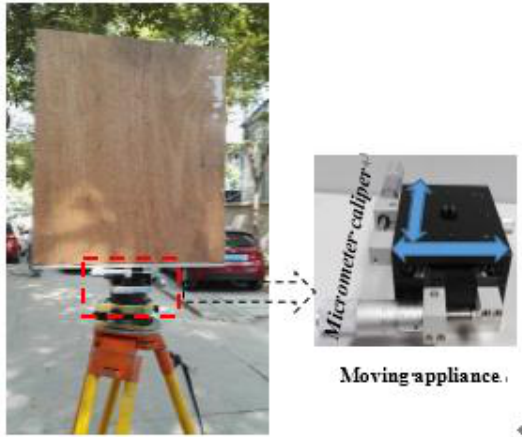
Figure 4. The monitoring surface. A plane board was mounted on a tripod via a moving appliance, by which the board could be moved along two perpendicular directions.